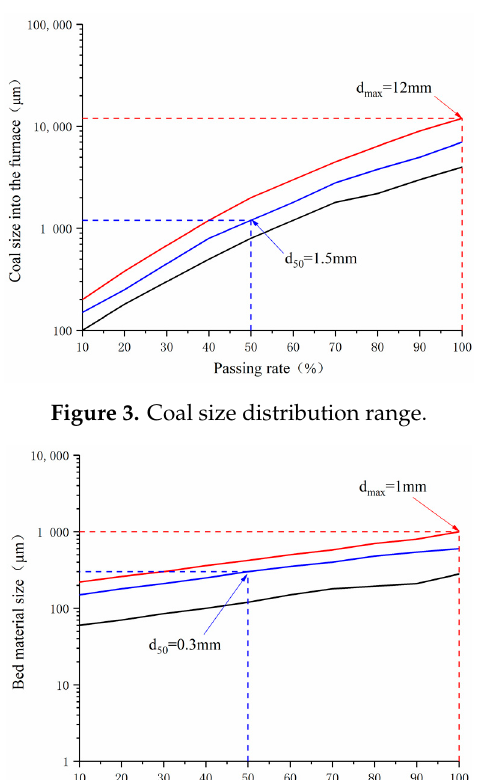
Figure 3. Coal size distribution range.